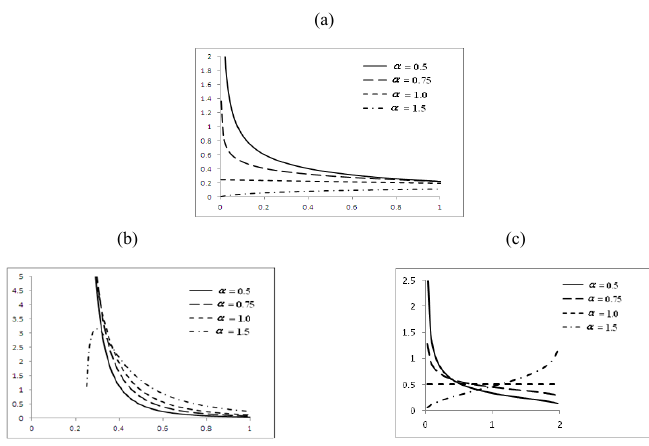
Figure 1 { The density curves of gamma generated (a) exponential distribution with cdf G ( x ) = 1 (cid:0) e (cid:0) 0 : 25 x , x > 0; (b) Pareto distribution with cdf G ( x ) = 1 (cid:0) ( 0 : 25 and (c) uniform distribution with cdf G ( x ) = x